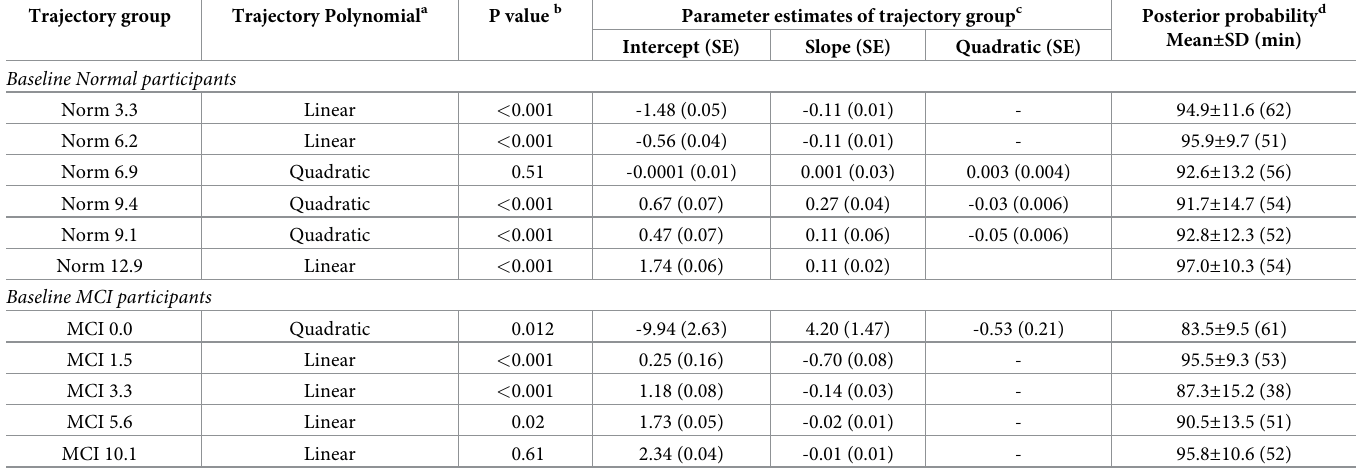
Table 3. Description of estimated trajectories for baseline normal and MCI participants. Trajectory groups are named based on the baseline diagnosis and baseline mean RAVLT delayed recall. Trajectory group